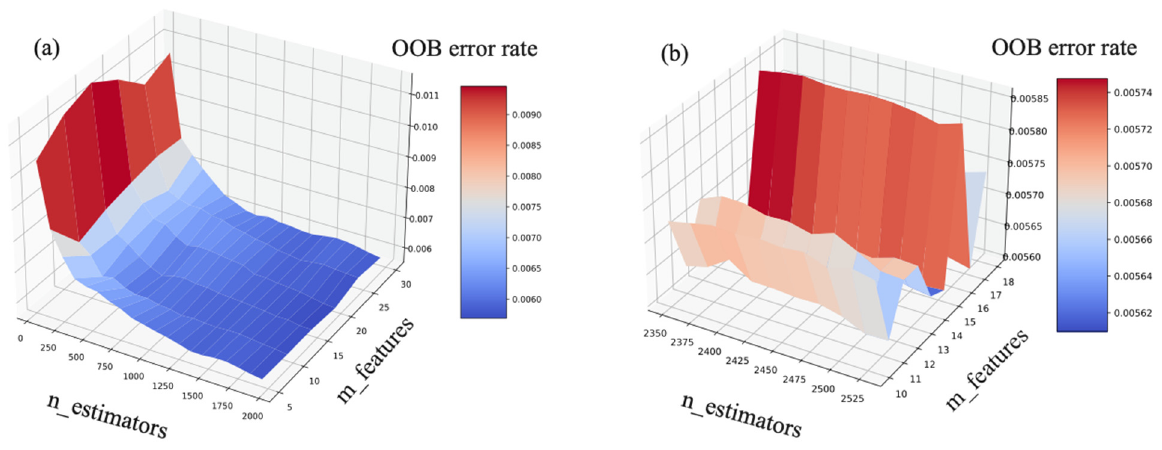
Figure 2. Parameter optimization in the RF model based on grid search: ( a ) Coarse search result. ( b ) Detailed search result.